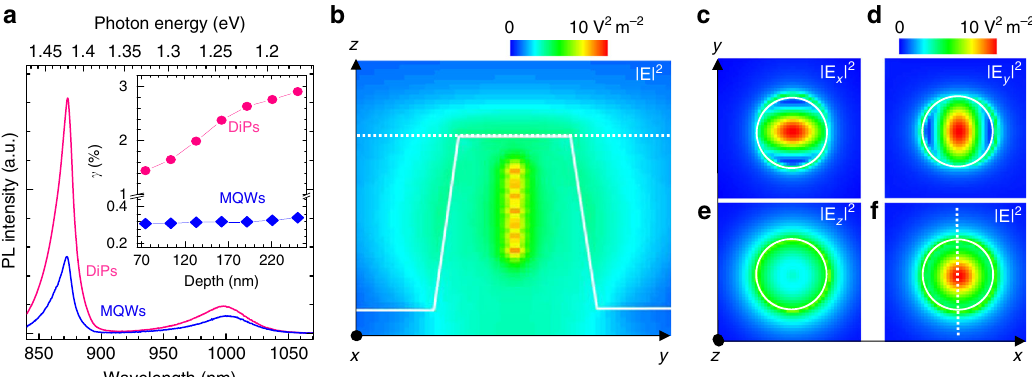
Fig. 2 Enhanced light absorption and extraction at room temperature. a Photoluminescence (PL) spectra from the GaNAs nanodisk-in-GaAs nanopillars (DiPs) and the multiple quantum wells (MQWs) structure under unpolarized laser excitation at 800 nm. The inset shows the detection ef fi ciency, γ , of both structures as a function of the dipole-emitter depth, i.e., the nanodisk (ND)/QW position from the top surface. b The side view of the fi nite difference time domain (FDTD) simulations of the squared electric- fi eld amplitude (proportional to the light intensity) from the GaNAs NDs with distances of 75, 104, 133, 162, 191, 220, and 250 nm from the top surface. The simulation was taken at the middle cross-section of the DiP as marked by the dashed line in f . c – e The top views of the FDTD simulations of the ND light emission intensity with x , y , and z polarization components, respectively, together with that of the total PL intensity ( f ). The images are obtained in the plane indicated by the dashed line in with smooth side walls and a rather uniform size distribution, manifesting high quality of the nanofabrication. From the mag- ni fi ed SEM image on an individual NP shown in Fig. 1b, the average diameter, d , of the NPs is found to gradually increase from the top, d top = 240 ± 10 nm, to the bottom, d bottom = 360 ± 10 nm, over the height, h , of 370 ± 10 nm. The seven etched dilute nitride GaNAs NDs within each NP are highlighted in red, with the fi rst ND at a distance of 70 nm from the top surface. The periodic modulation of the conduction band (CB) edge along the NP axis is depicted on the left side of Fig. 1b, where the CB energy is lower in the NDs due to incorporation of N 41 . The energy of the valence band (VB) edge of the NPs, on the other hand, is rather unperturbed 42 (not shown here), as the incorporated N states predominantly interact with the CB and the alloy-induced strain in the NDs is relaxed owing to the DiP geometry (see Supplementary Note 1).